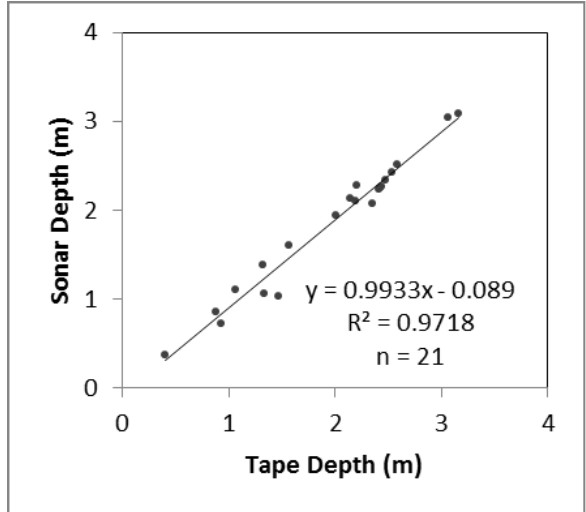
Figure 4: Lead line measurements against hydrolite